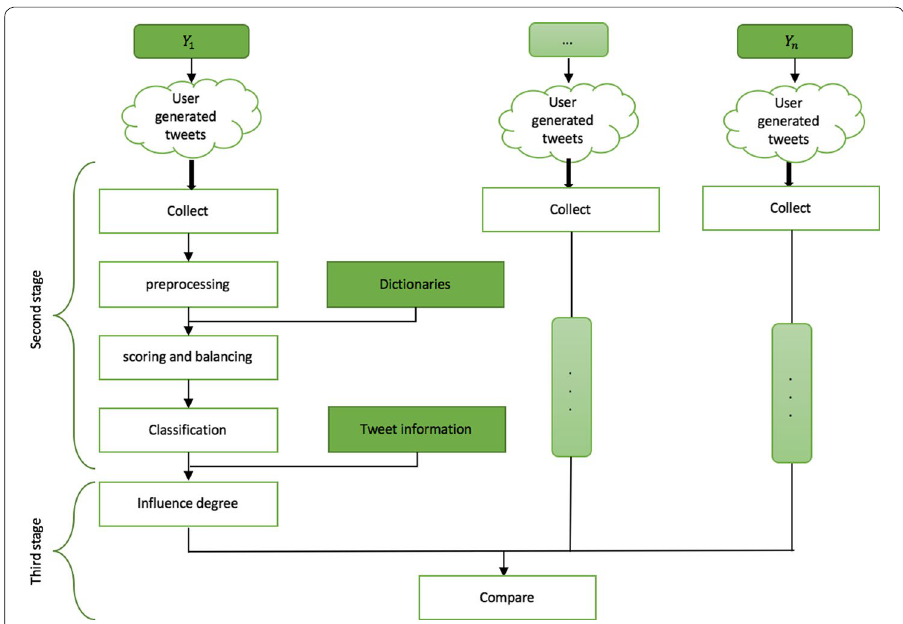
Fig. 3 Second and third stages of the